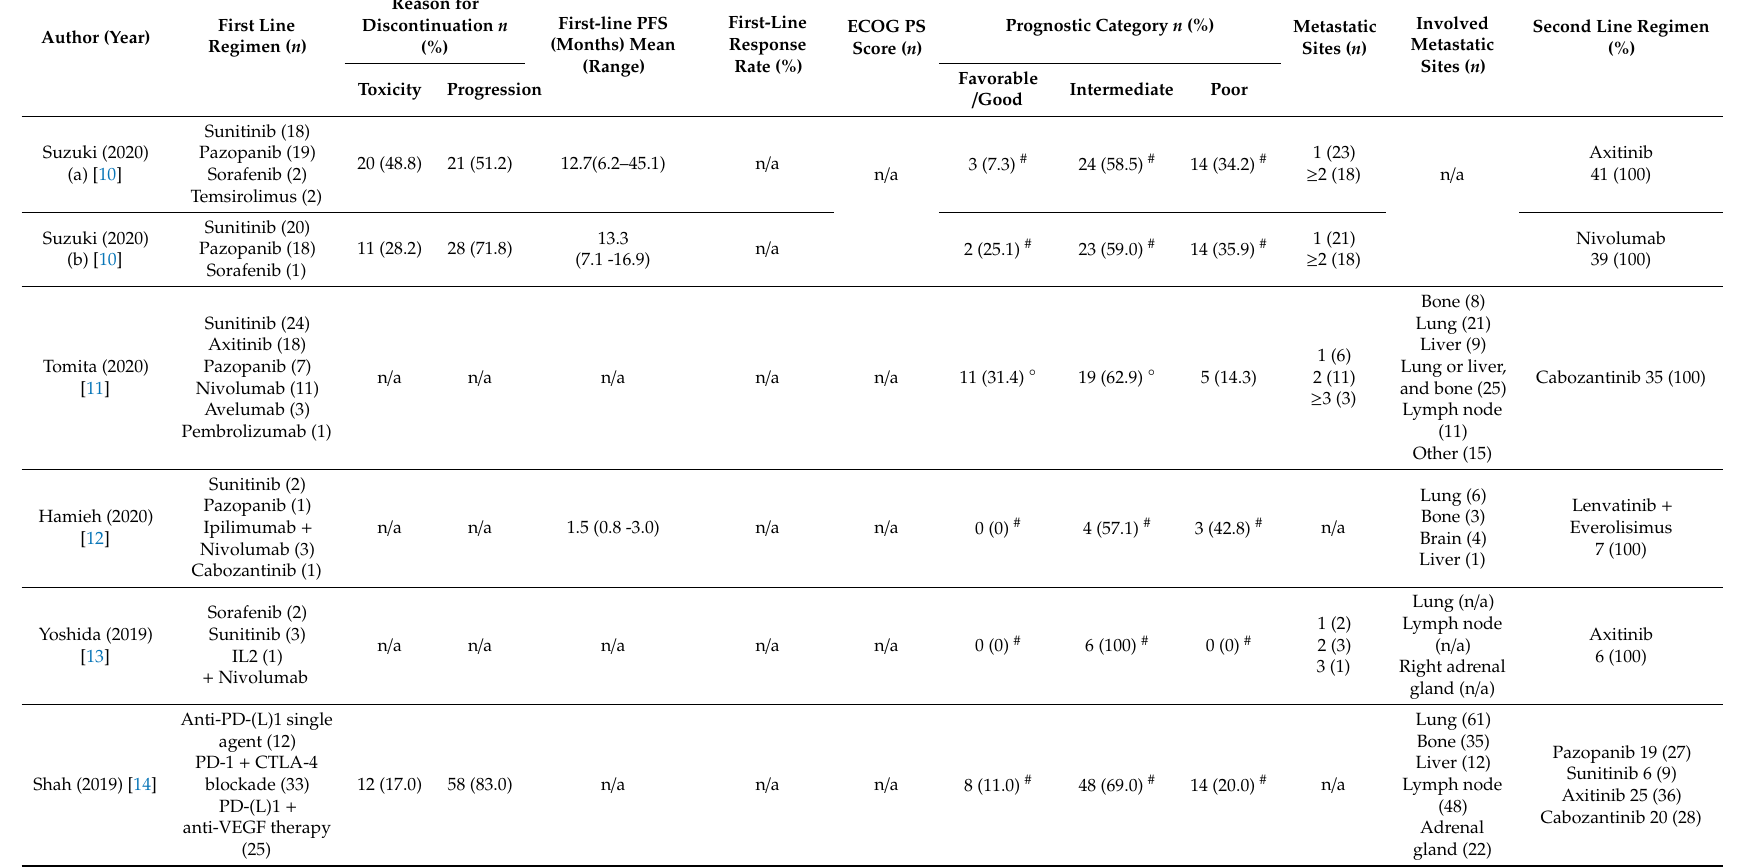
Table 2. Treatment history and disease characteristics at initiation of second line